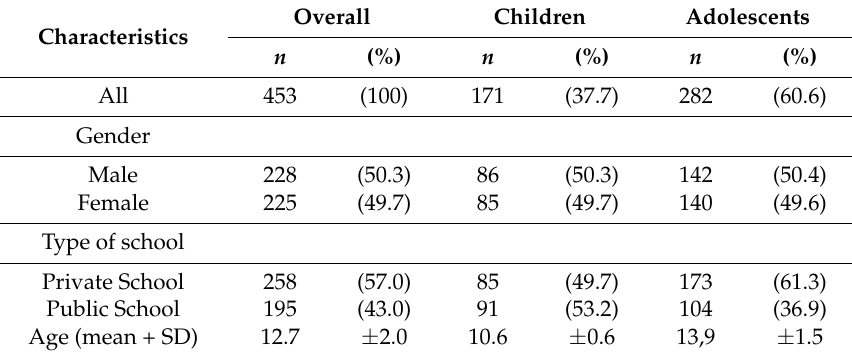
Table 1. Descriptive sociodemographic data of the participants.